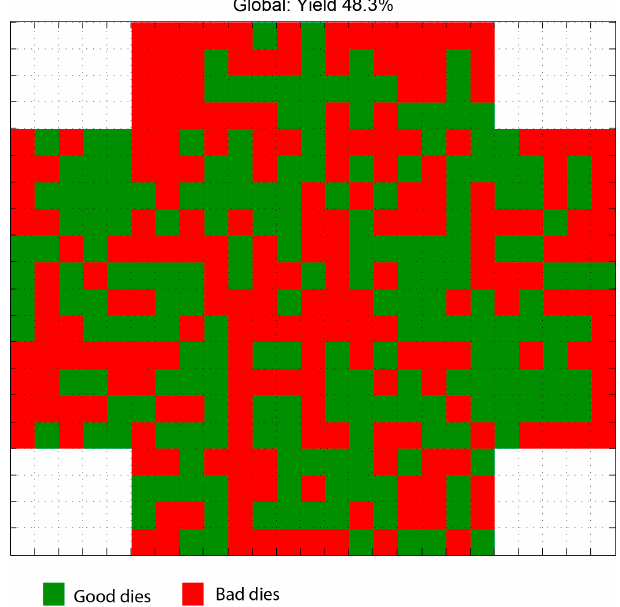
Figure 15. Results from the process yield.